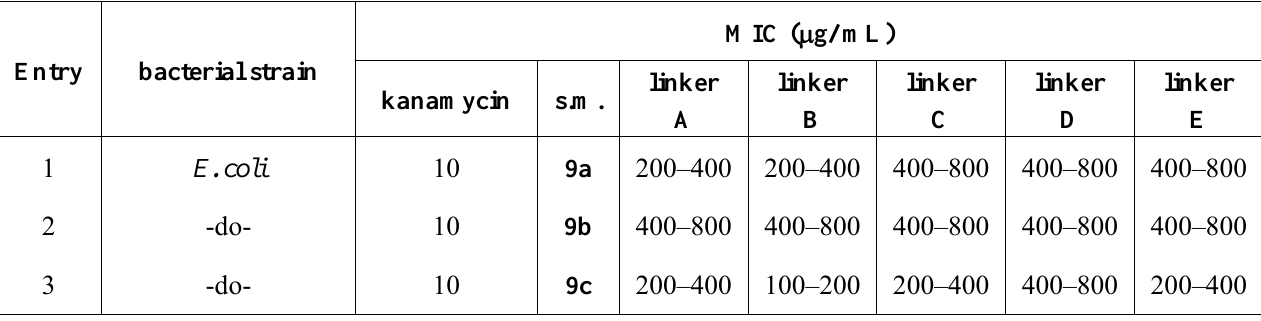
Table 3. MIC values (µg/ mL) as determind by the fluorescence-based cell growth assay.